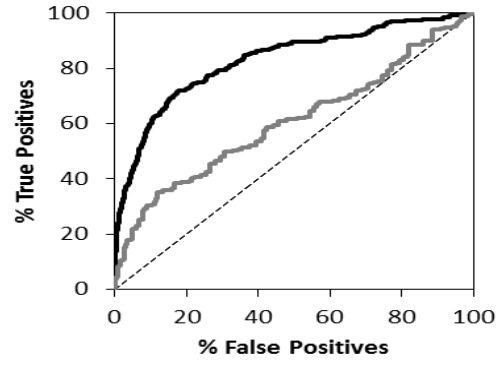
Figure 1. ROC curves resulted in the retrospective SBVS campaign. The black lines represent the ROC curves when the results were ranked by ChemPLP scores, while the grey lines represent the ROC curves when the results were ranked by Tc-PLIF values. The dashed lines represent random selection.